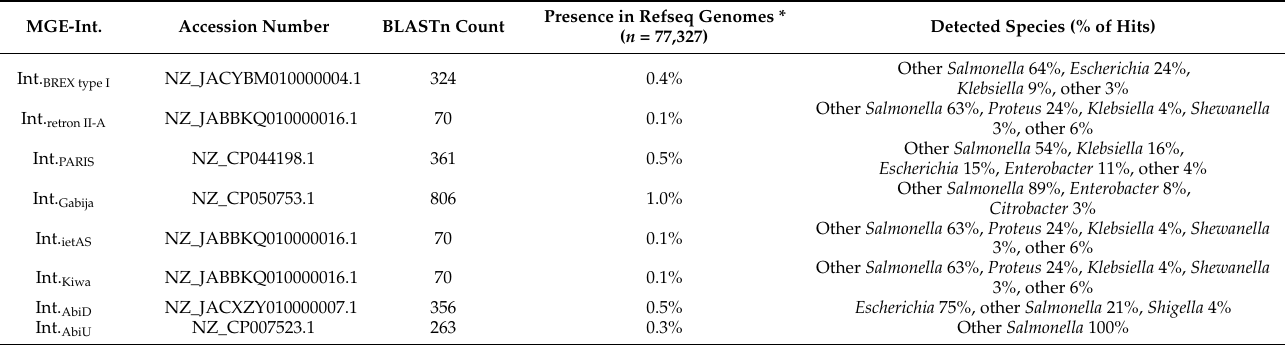
Table 4. Presence of associated anti-phage defense system integrases alone in non- S. Typhimurium